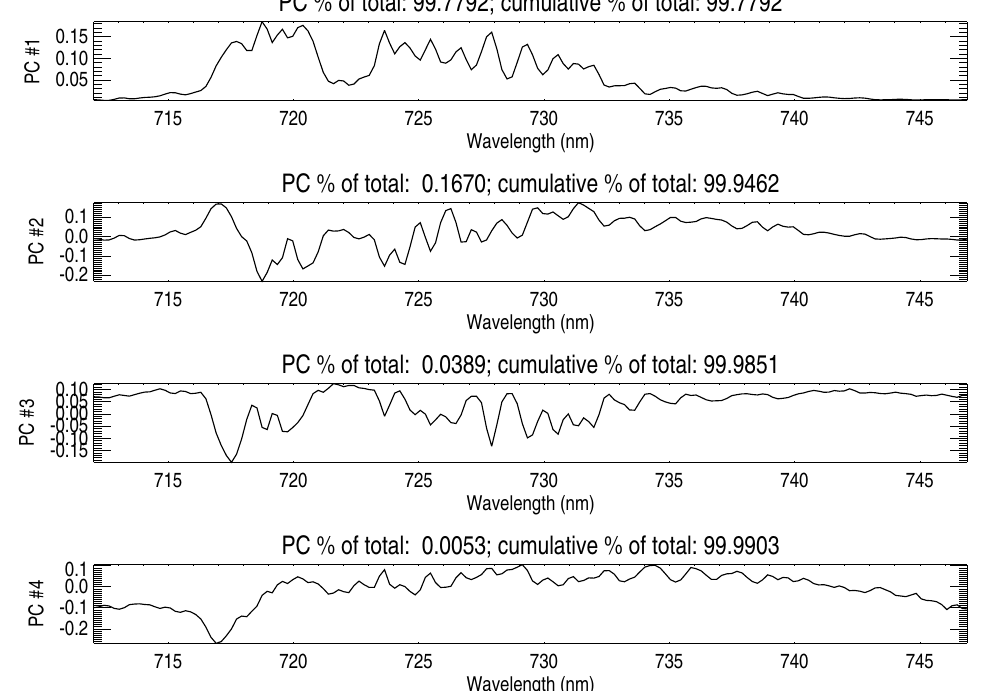
Fig. 6. Similar to Fig. 5 but the PCA is conducted using actual GOME-2 data taken over ice- and snow-covered surfaces, the Sahara desert, and cloudy ocean.